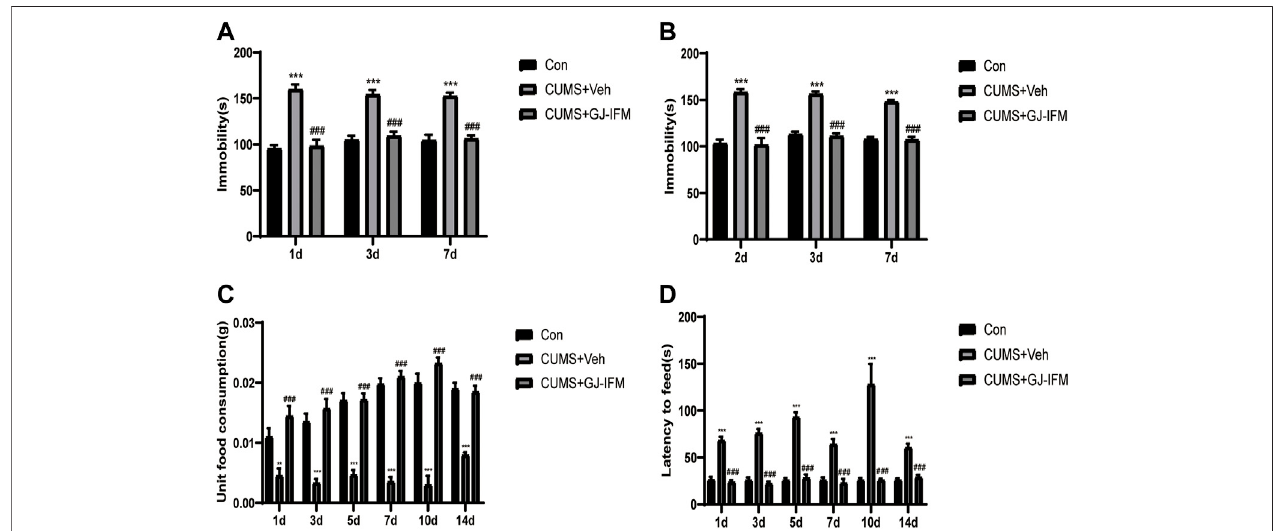
FIGURE8| The enduring effects ofasingle doseofGJ-IFM (100 mg/kg) treatmentonTST, FST,NSFT inCUMSmice. (A) Asigni fi cantdecrease inimmobilitytime inTSTfrom1to7 dwasobservedinthemicetreatedwithGJ-IFM.One-wayANOVA,*** p < 0.001,control vs .CUMS+vehicle. ### p < 0.001,CUMS+vehicle vs .CUMS + GJ-IFM. (B) CUMS mice signi fi cantly increased immobility time in the FST. GJ-IFM signi fi cantly reduced prolonged immobility time induced by CUMS from 2 to 7 d. One-way ANOVA, *** p < 0.001, control vs . CUMS + vehicle. ### p < 0.001, CUMS + vehicle vs . CUMS + GJ-IFM. (C) GJ-IF signi fi cantly decreased unit food consumptionduring10 mintest ofNSFfrom1to14 d.One-wayANOVA, ** p < 0.01,*** p < 0.001,control vs .CUMS+vehicle. ### p < 0.001,CUMS+vehicle vs .CUMS + GJ-IFM. (D) GJ-IF signi fi cantly decreased the time of latency to eat during 10 min test of NSFT from 1 to 14 d. One-way ANOVA, *** p < 0.001, control vs . CUMS + vehicle. ### p < 0.001, CUMS + vehicle vs . CUMS +